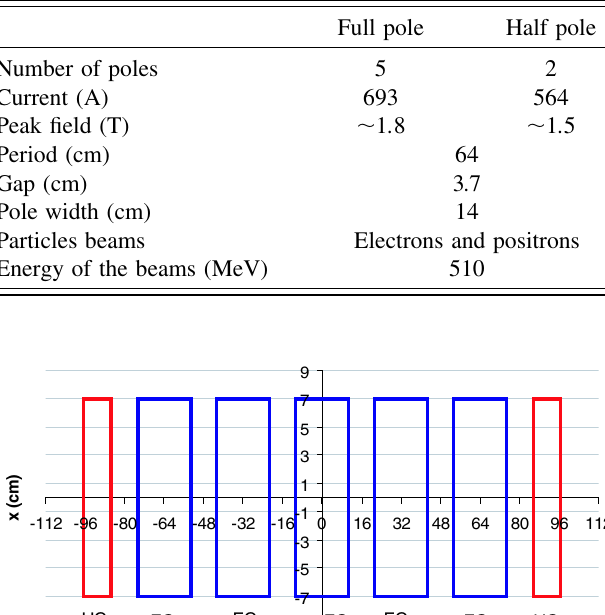
TABLE I. Wiggler specifications, particles, and energy beams circulating in the main ring of DA (cid:1) NE.